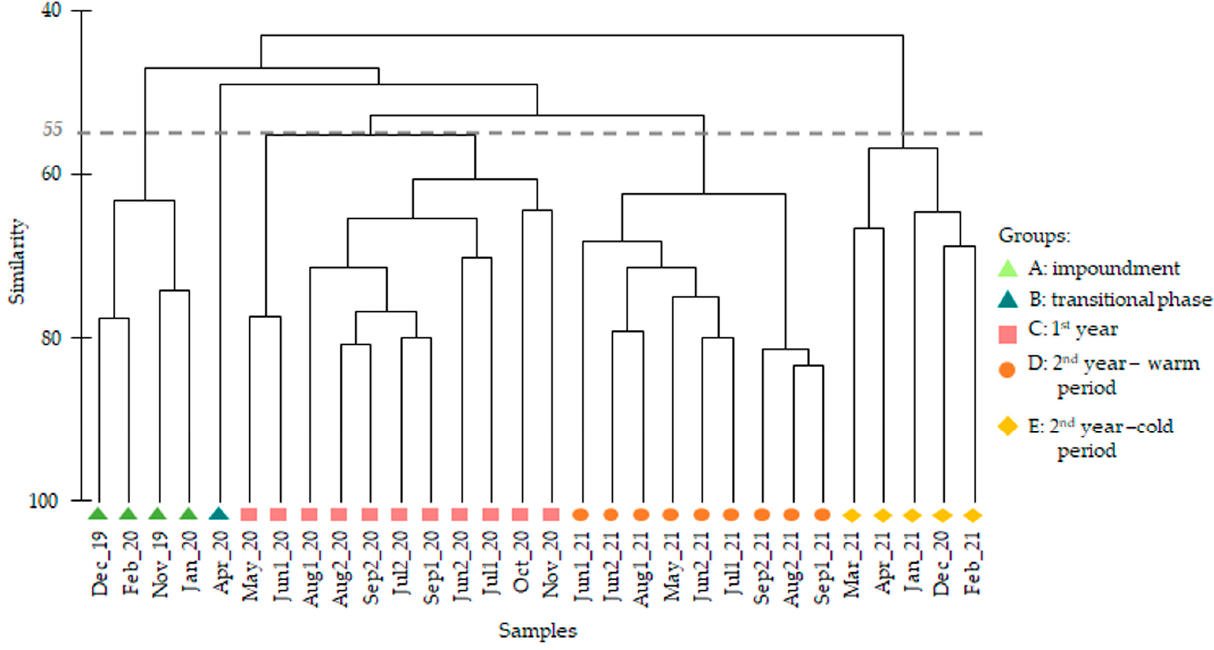
Figure 3. Dendrogram for clustering based on the Bray–Curtis similarity index applied on pres- ence/absence data for the samples from the Moglicë Reservoir.